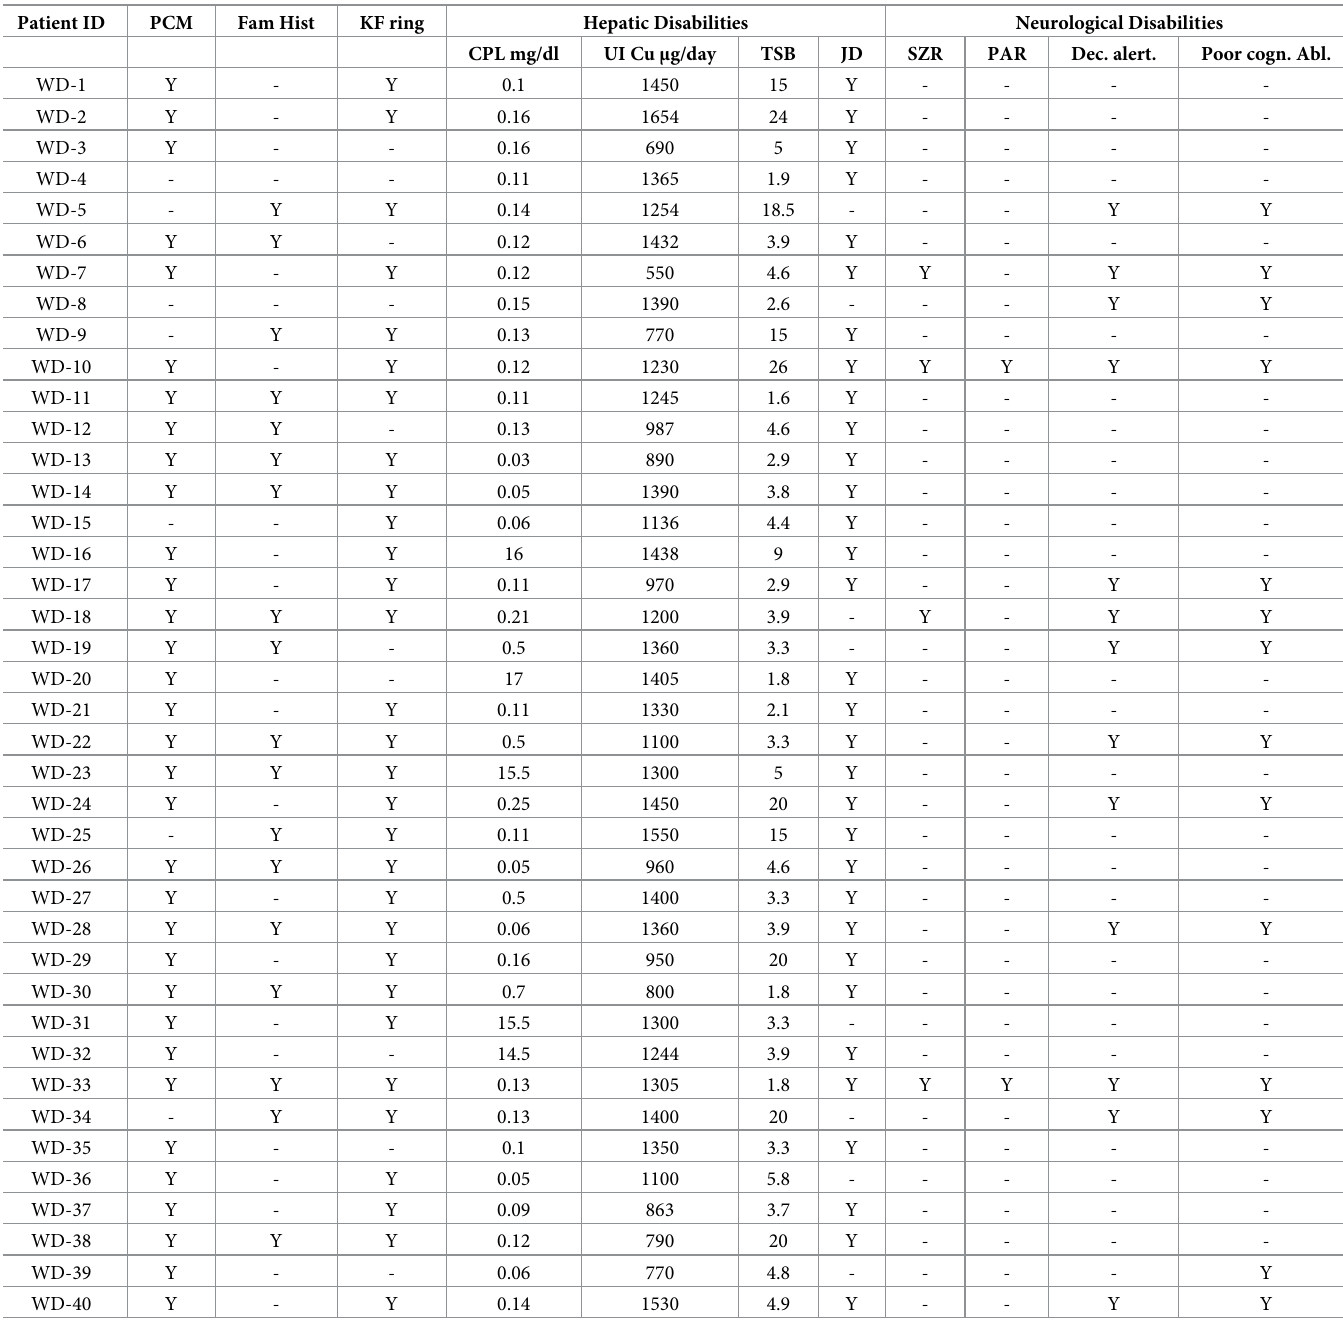
Table 2. Clinical profile of enrolled 40 patients with Wilson’s